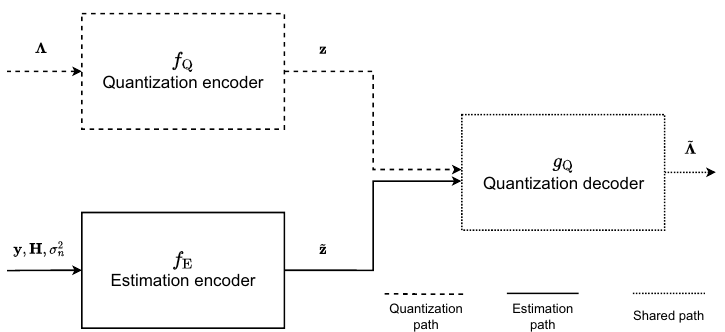
Fig. 1 High-level block diagram of the EQ-Net architecture. In the first training stage, and at test time for the soft bit quantization task, the dashed blocks are learned and used for inference, respectively. In the second training stage, the decoder g Q is kept frozen while training the estimation encoder f E . During deployment, the top or bottom signal paths are used to output the reconstructed (for quantization) or estimated (for estimation) soft bits ˜ (cid:31) ,